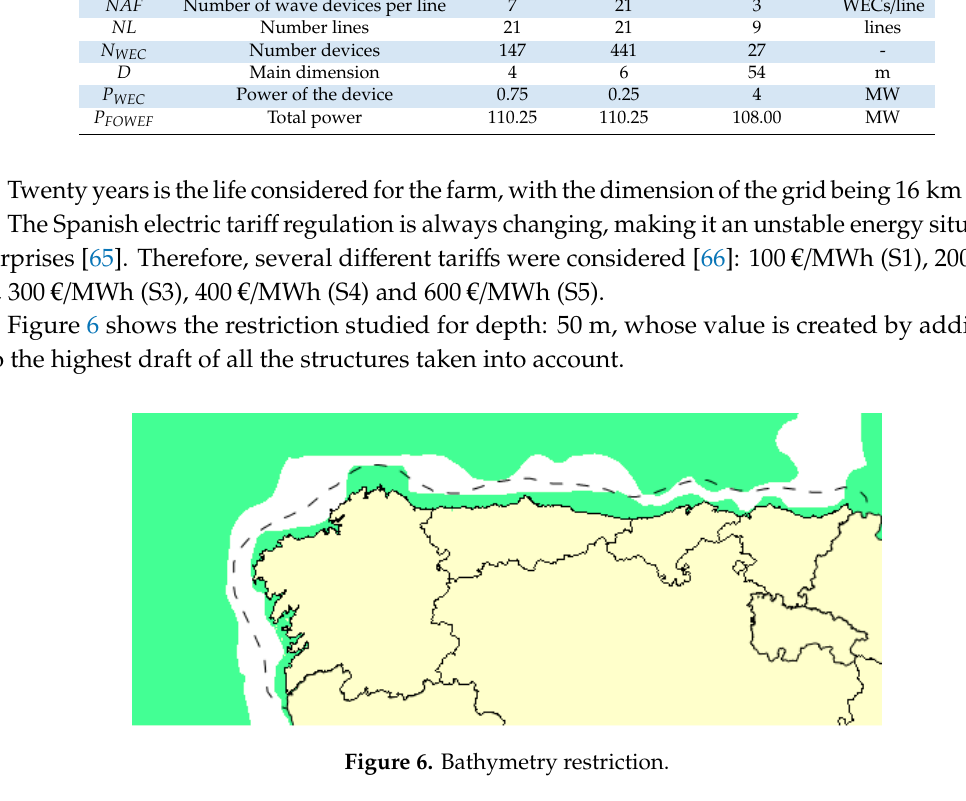
Table 1. Properties of the farms considering different converters.